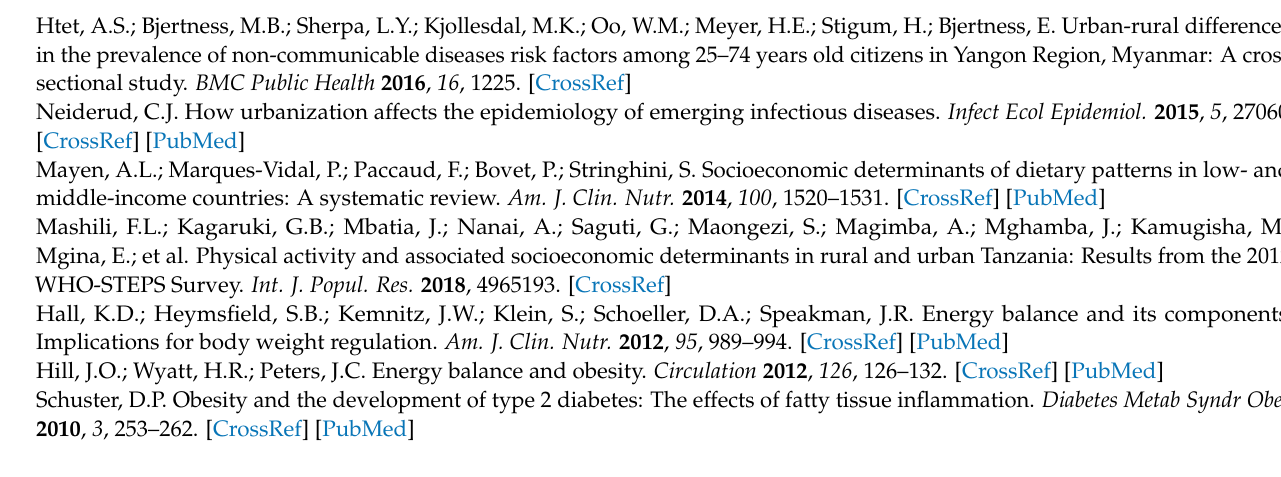
Figure S2. The changes of physical activity levels (A & B) and sedentary time (C) in urban and rural subjects after 1-year of living in an urban environment. Table S1. Mediation analysis of the effect of dietary intake on the differences of adiposity profiles in urban and rural subjects at baseline. Table S2. The levels of physical activity and sedentary time measured with GPAQ in urban and rural subjects at baseline. Table S3. Characteristics of study population at 1-year follow-up time. Table S4. The effect of the differences in protein intake changes on the differences of BMI increase after 1-year between urban and rural